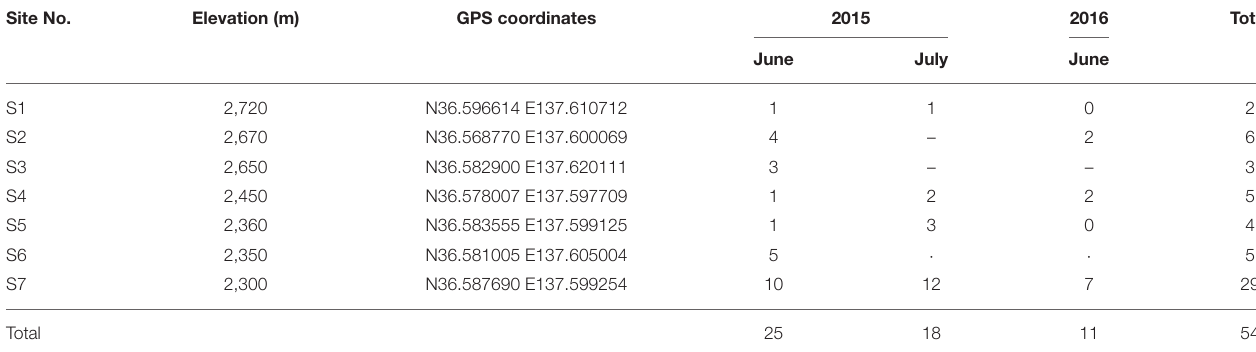
TABLE 1 | List of study sites showing the number of samples collected. Site No.